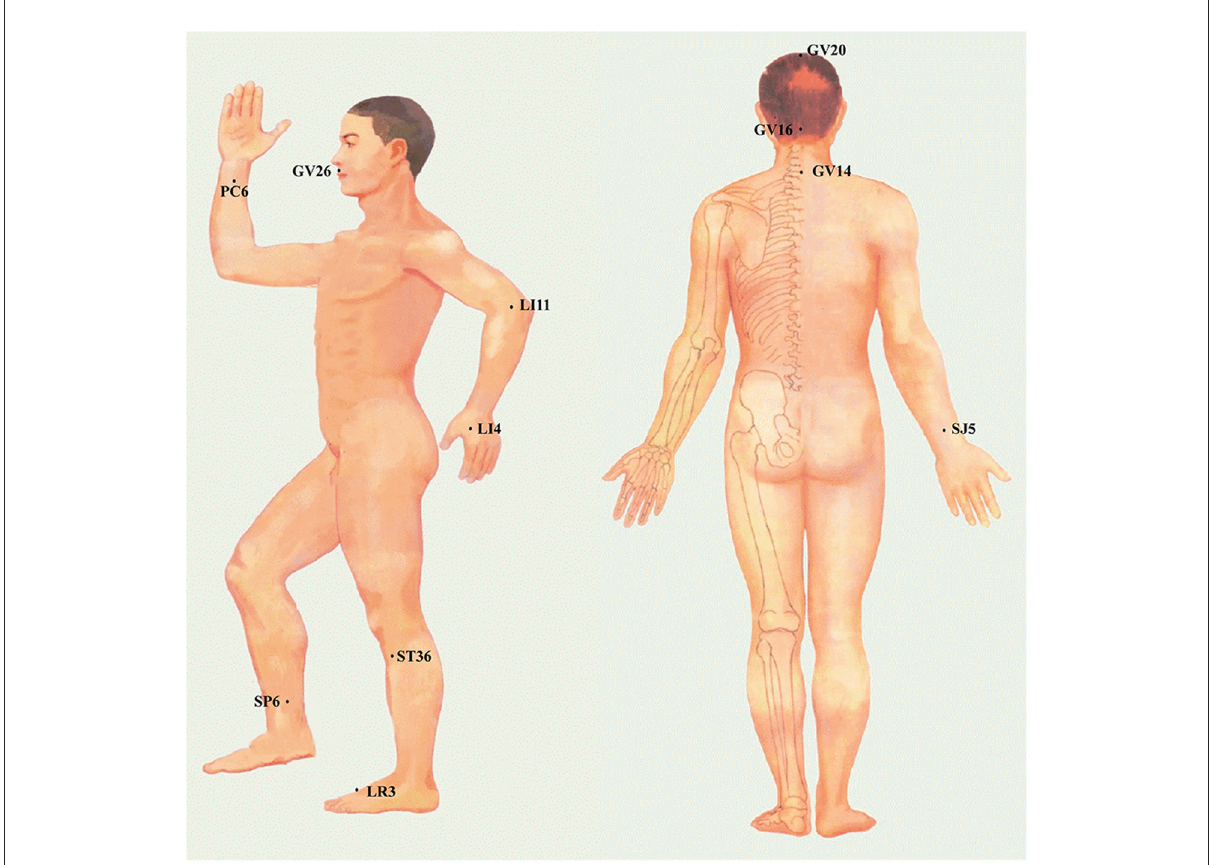
FIGURE5 The specific location of acupoints is frequently applied to regulate CBF in the ischemic stroke.